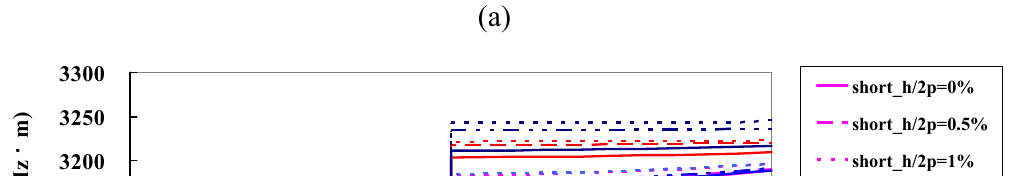
Figure 3. Dispersion curves of Rayleigh wave under the shorted and open grating on Al /ST- cut quartz at M/p = 0.5: (a) The real part of normalized wave number. (b) The imaginary part of normalized wave